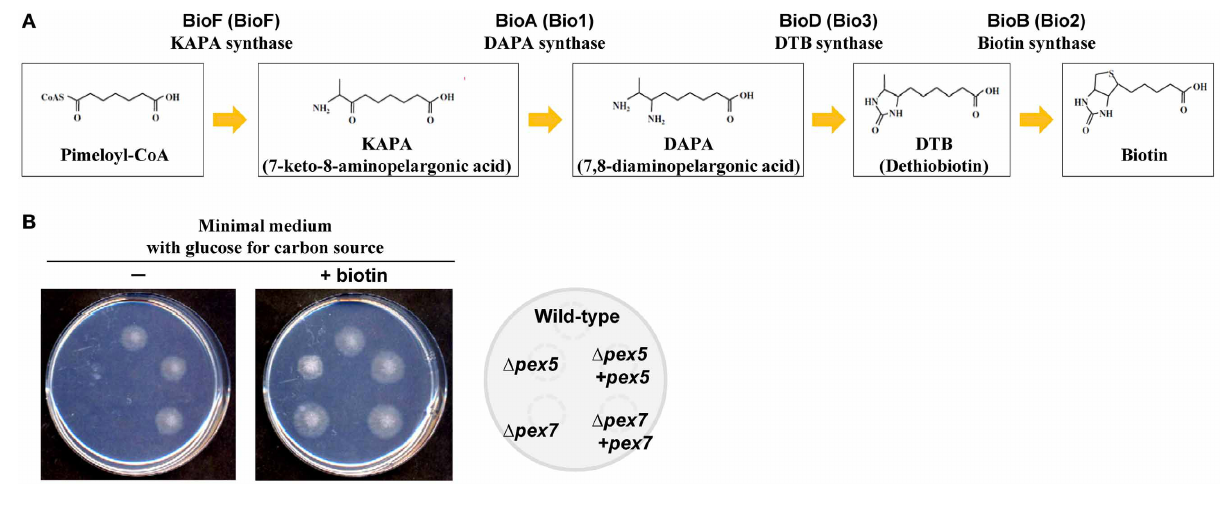
FIGURE 4 | Biotin biosynthetic pathway and biotin auxotrophy in peroxisome-deficient strains. (A) The final four reactions of the biotin biosynthetic pathway and involved enzymes from fungi and plants (in parentheses). (B) Growth impairment of strains defective in peroxisomal